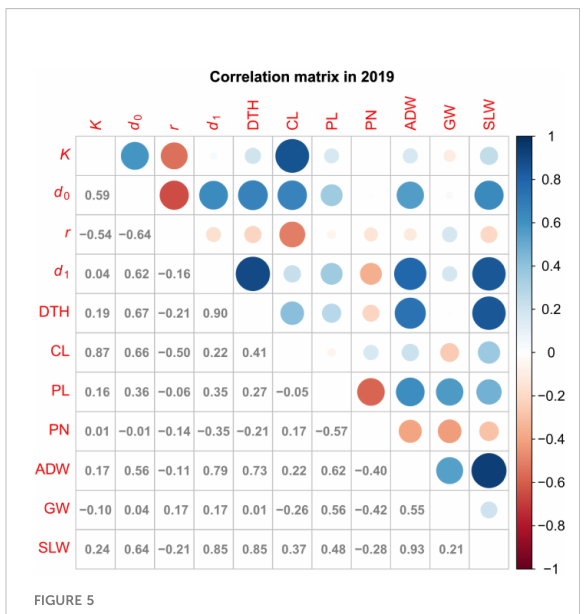
FIGURE 5 Correlation plot of parameters and traits in 2019. Values are correlation coef fi cients (cor); circles present them by color and